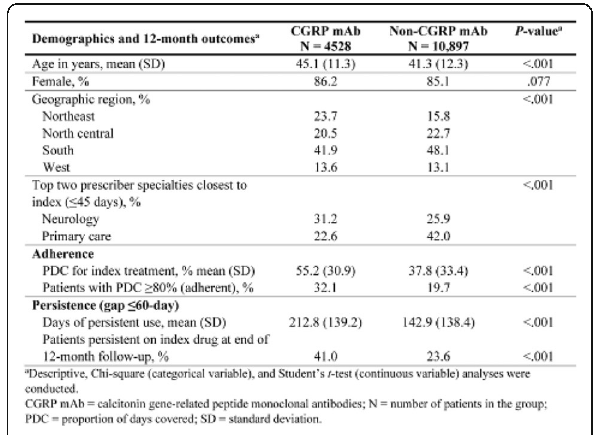
Table 1 (abstract P0218). See text for description